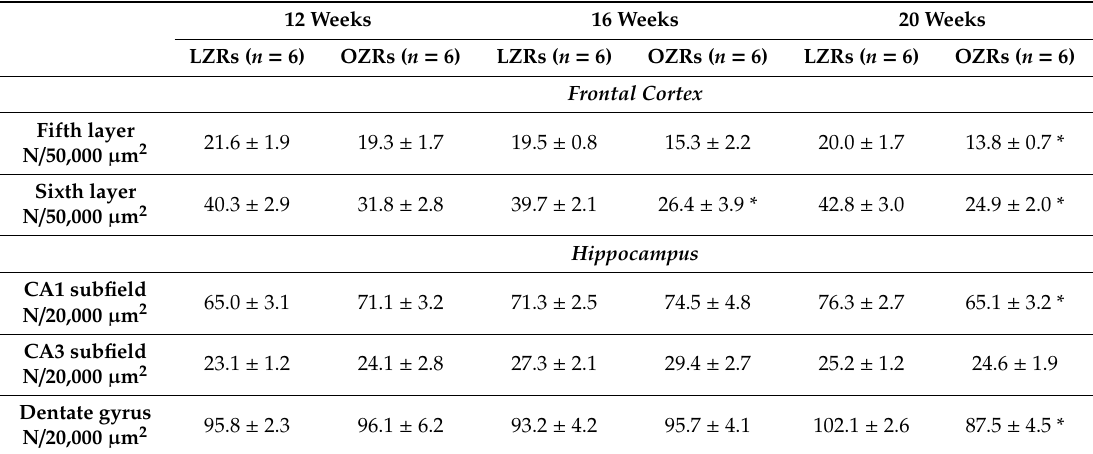
Table 2. Number of Neu-N positive neurons in frontal cortex and hippocampus of lean and obese Zucker rats at the di ff erent ages. 12 Weeks 16 Weeks 20